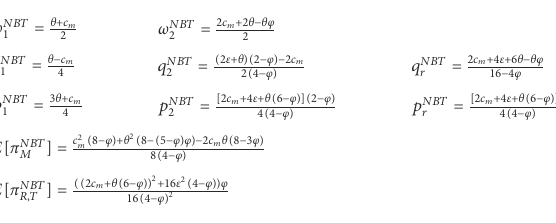
TABLE 6 The equilibrium outcomes of BCT